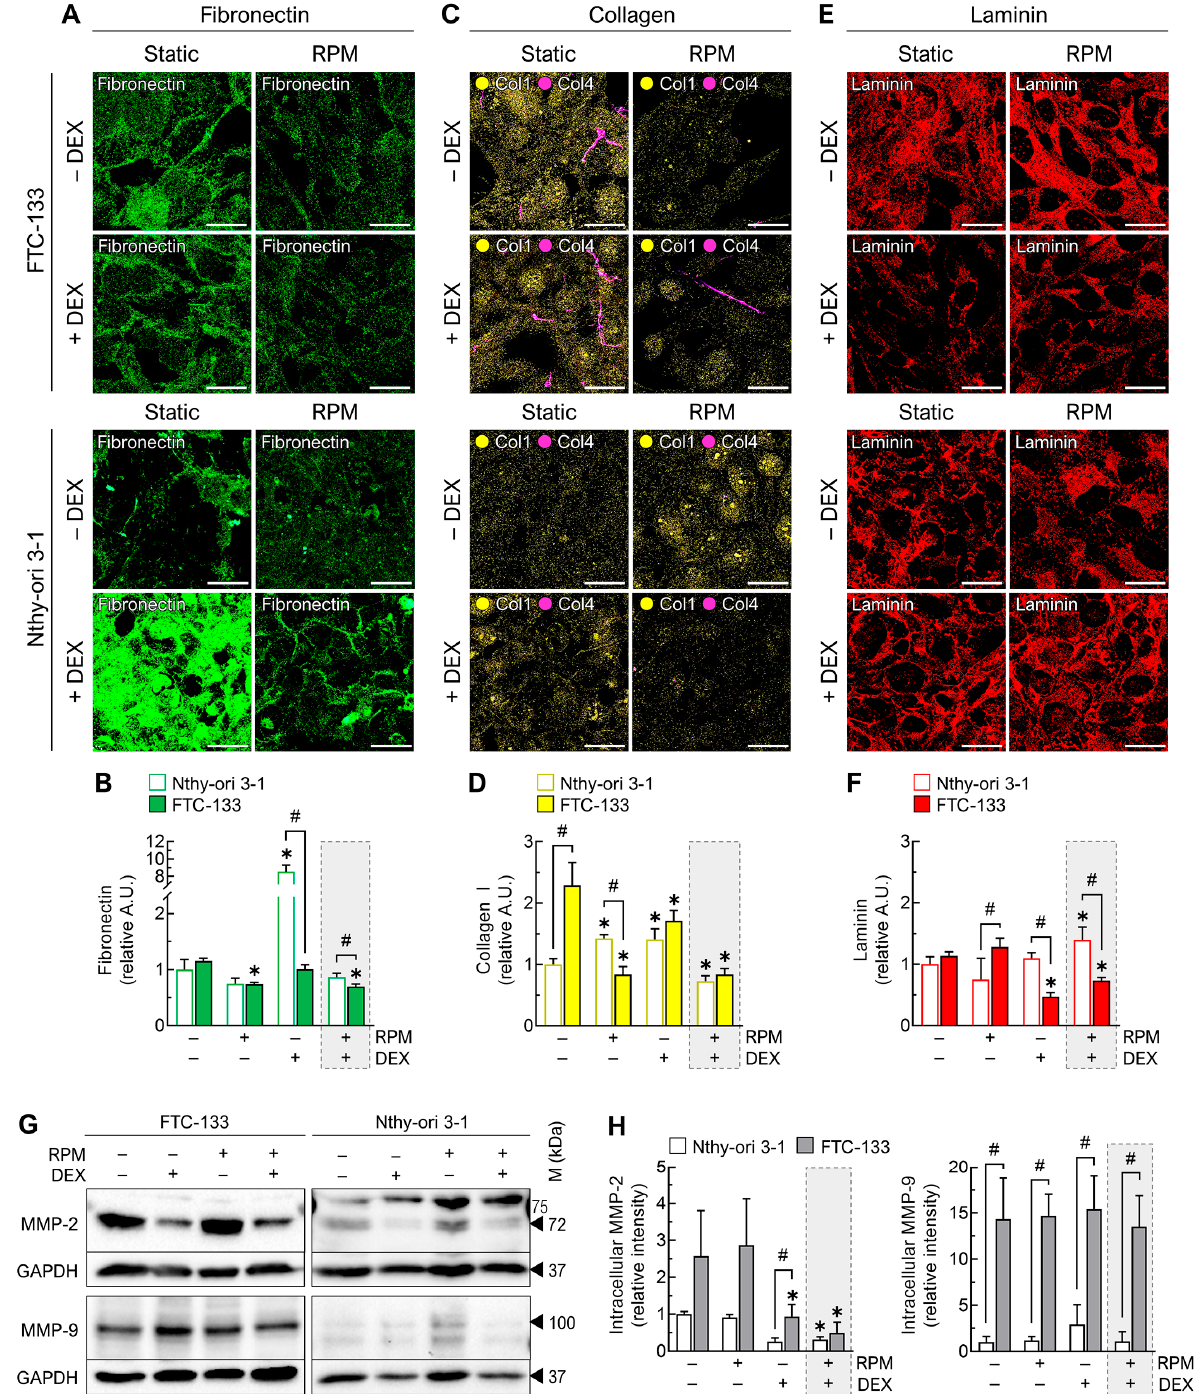
Figure 4. Effect of DEX (1000 nM) and random positioning on the ECM of FTC-133 and Nthy-ori 3-1 cells after 3 days. ( A ) Immunofluorescence of fibronectin; ( B ) fluorescence-based quantification of fibronectin under the different culture conditions ( n = 5); ( C ) immunofluorescence of collagen I (yel- low) and collagen IV (purple); ( D ) fluorescence-based quantification of collagen I under the different culture conditions ( n = 5); ( E ) immunofluorescence of laminin; ( F ) fluorescence-based quantification of laminin under the different culture conditions ( n = 5); ( G ) intracellular protein levels of matrix metallopeptidases MMP-2 and MMP-9 indicated by Western blot (see also Supplementary File S1); ( H ) densitometric quantification of Western blot proteins ( n = 3). Scale bars: 300 µm. * p < 0.05 vs. control condition ( − DEX/ − RPM); # p < 0.05.